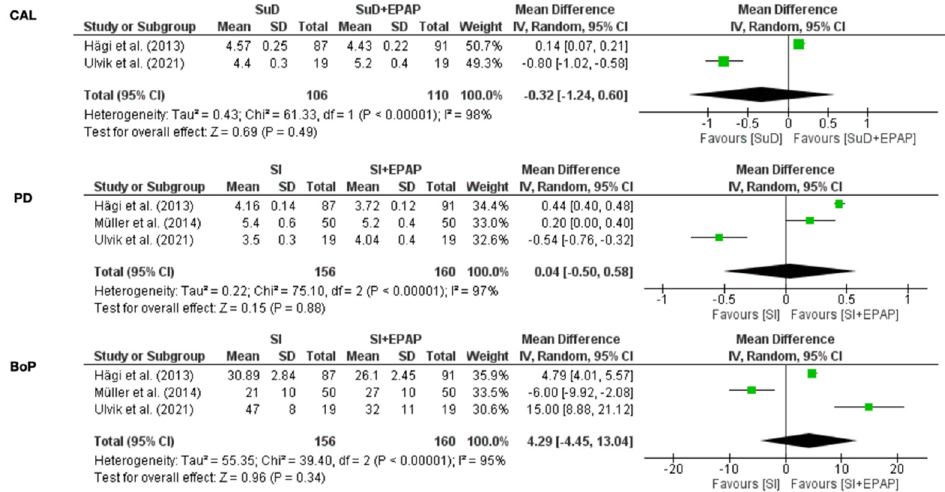
Figure 4. Erythritol in supportive periodontal